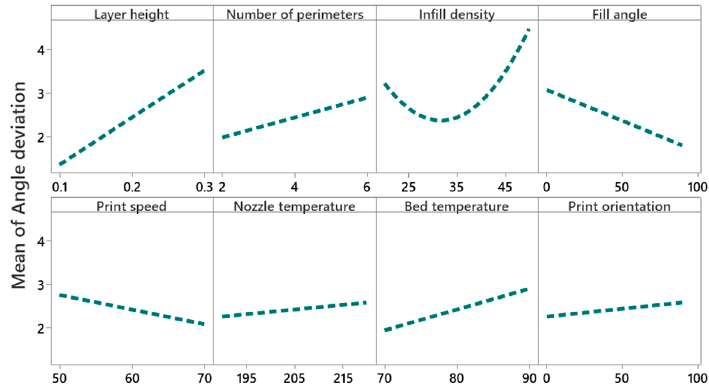
Figure 13. Main effect plot for angular deviation.